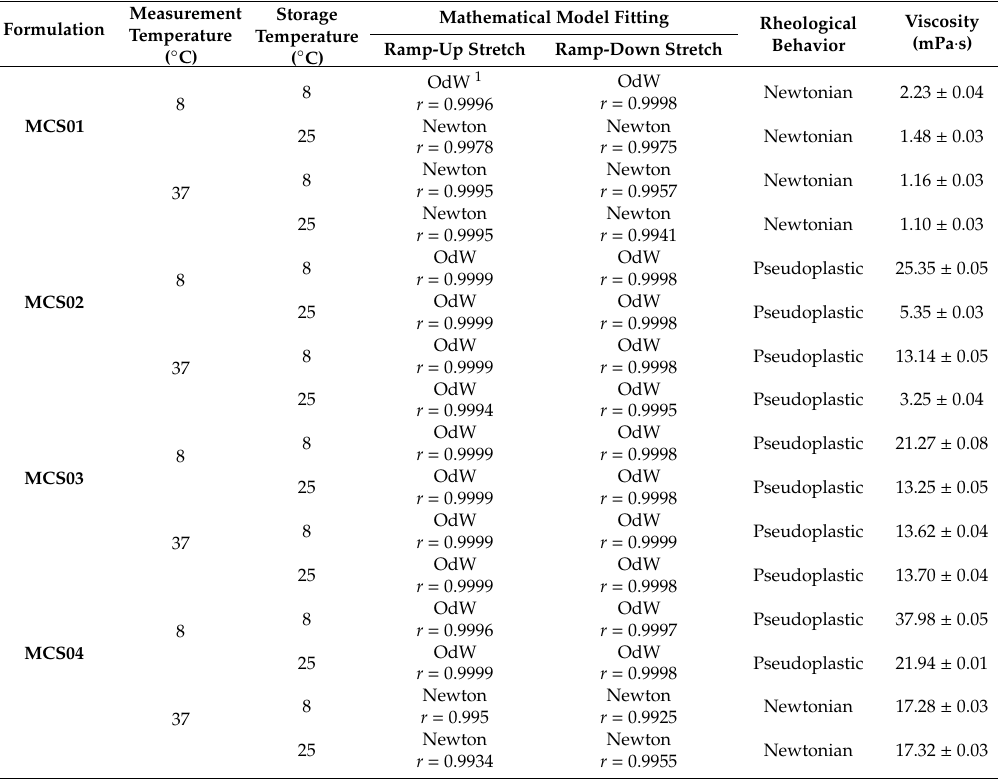
Table 3. Rheological characterization 24 h after preparation ( t 0 ) of polymeric solutions at di ff erent temperatures of measurement and